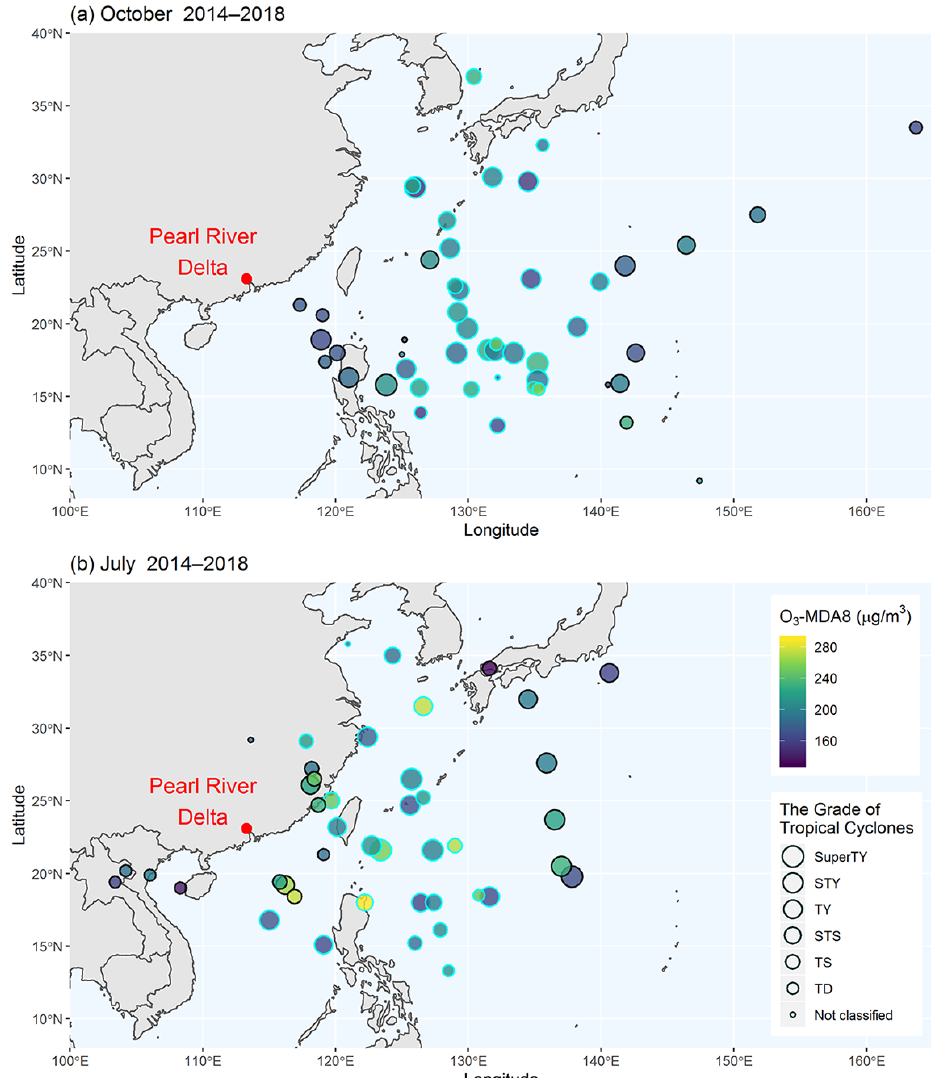
Figure 1. The location and intensity of typhoons at 14:00LT on all O 3 pollution days with typhoons, and the corresponding O 3 MDA8 concentrations (maximum values in the nine municipalities of the PRD) on the same days during (a) October and (b) July in 2014–2018. The points with cyan borders indicate the typhoon-induced O 3 pollution days used in the comparisons. The grades of tropical cyclones (Chinese National Standard, GB/T 19201-2006) are as follows: SuperTY – super typhoon; STY – severe typhoon; TY – typhoon; STS – severe tropical storm; TS – tropical storm; TD – tropical depression; others are not